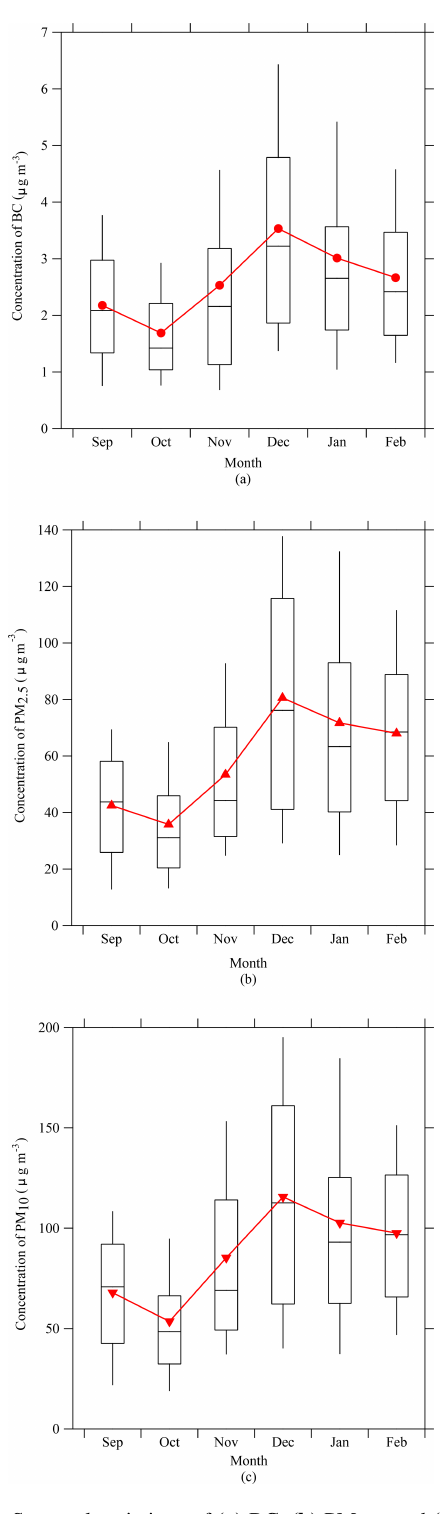
Figure 2. Seasonal variations of (a) BC, (b) PM 2 . 5 , and (c) PM 10 . The 10th, 25th, 50th, 75th, and 90th percentile values of each are shown in black, and red markers represent the monthly